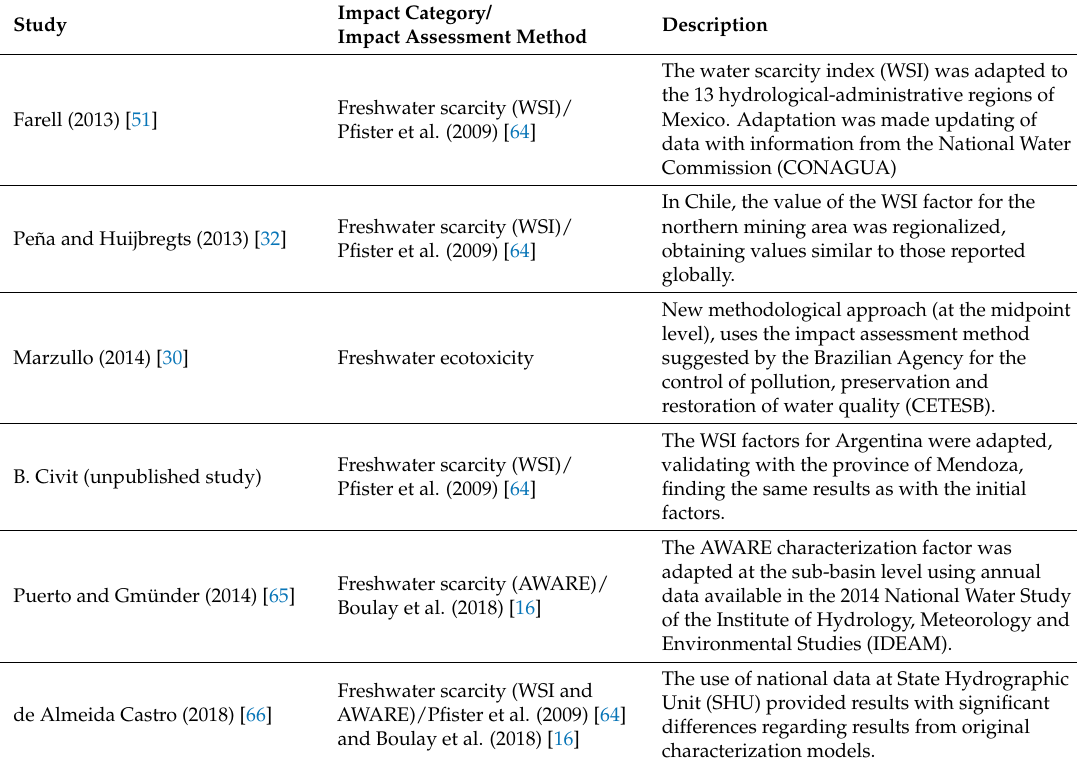
Table 5. Studies carried out to adapt impact assessment methods to the Latin American